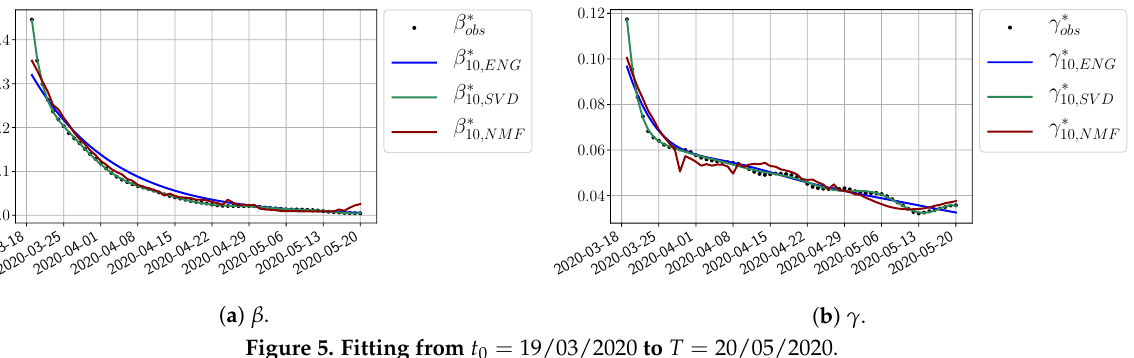
Figure 5. Fitting from t 0 = 19/03/2020 to T =